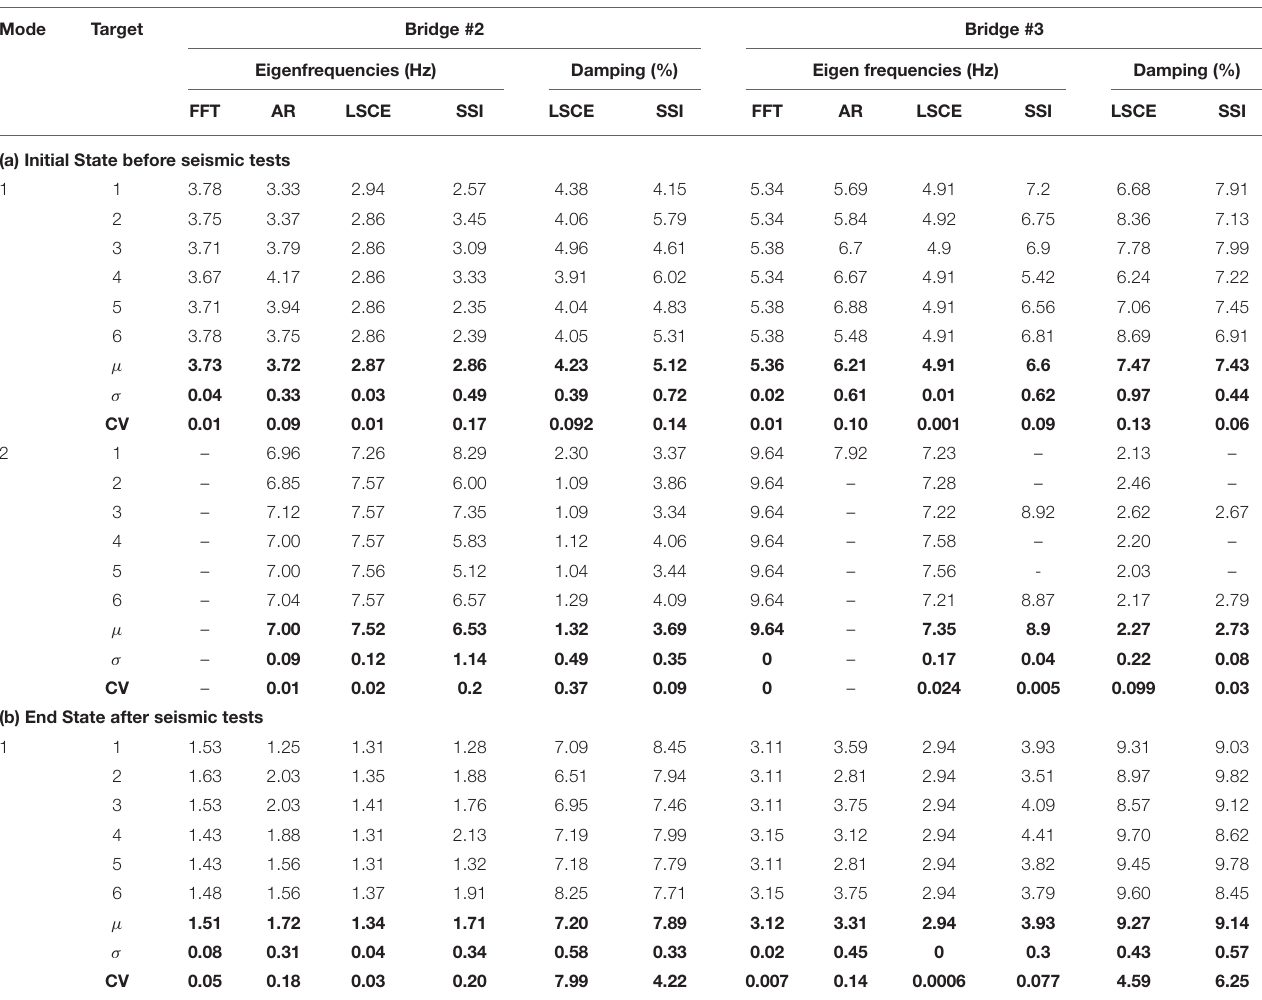
TABLE 5 | Estimated Eigen frequencies and damping ratios of the two bridge models along with the average and standard deviations from six targets.